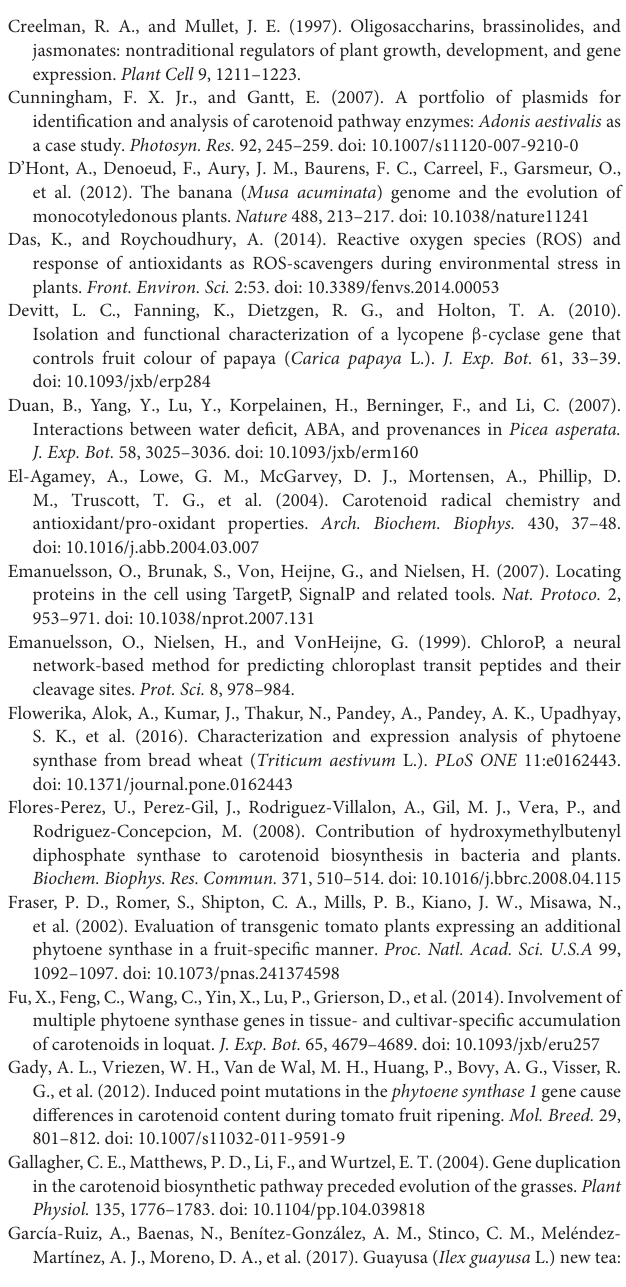
Supplementary Table S2 | Percentage identity of the predicted protein sequence of MaPSY . Supplementary Table S3 | Gene families and the exons and introns numbers in MaPSY homologs. Supplementary Table S4 | Structural features of three PSY homologs in banana. Supplementary Table S5 | Cis -regulatory elements in the promoter of MaPSY genes. Supplementary Table S6 | PSY protein sequences used for phylogenetic tree analysis in Figure